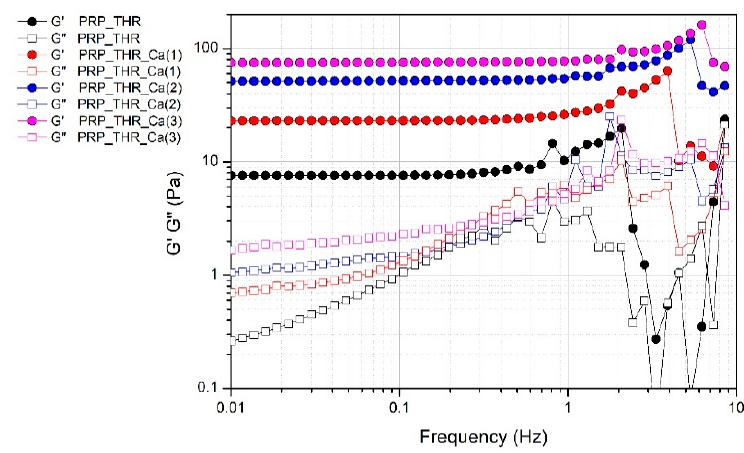
Figure 4. Variation of the elastic modulus (G’) and viscous modulus (G’’) over the applied frequency (0.1–10 Hz) for PRP after activation with thrombin (PRP_THR) and in presence of Ca 2+ at the three tested concentrations [PRP_THR_Ca(1), 7.7 mM; PRP_THR_Ca(2), 15.4 mM ; PRP_THR_Ca(3), 23.1 mM] from frequency sweep test at 25 °C.